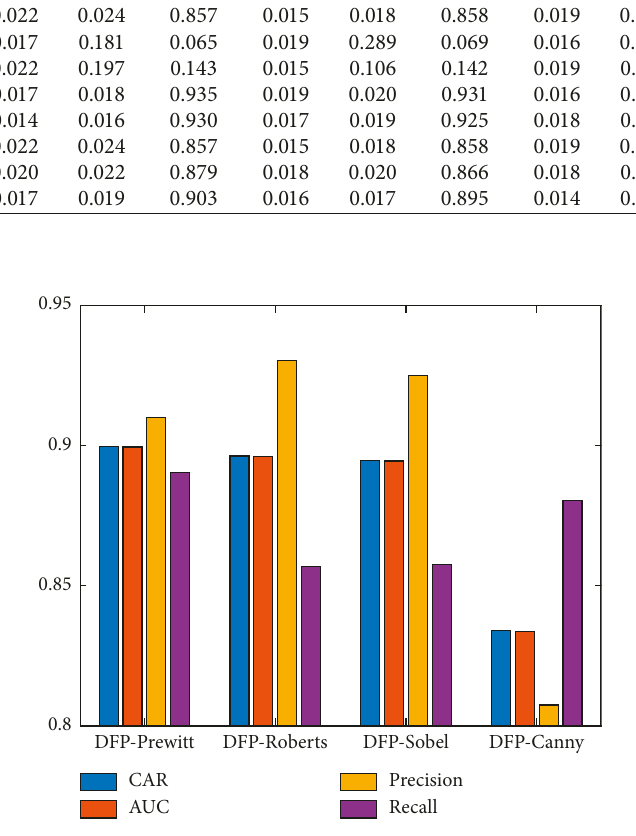
Figure 9: Model performance